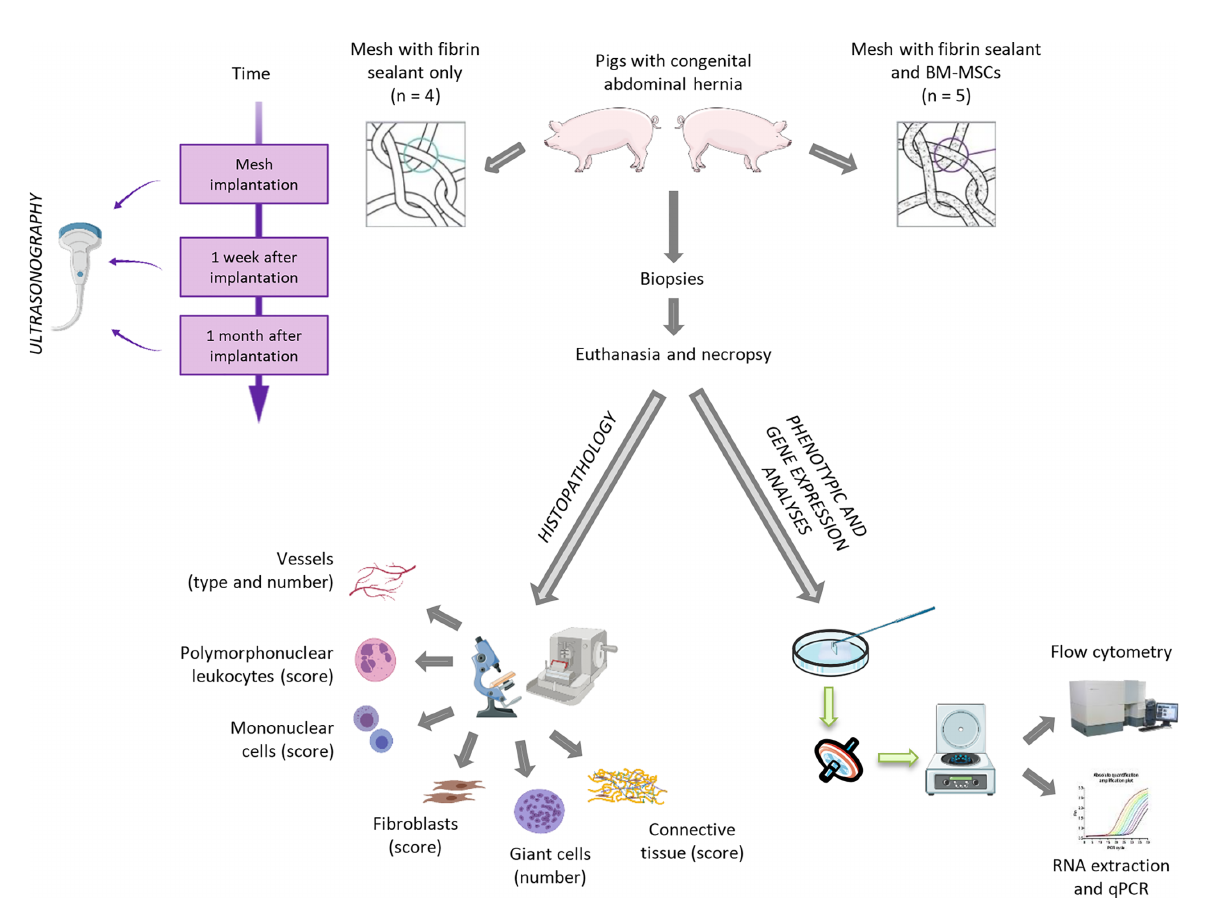
FIGURE 1 | Overview of the experimental approach. Large White pigs with a congenital abdominal non-incarcerated hernia were randomly divided into “ control ” and “ cell ” groups. Polypropylene surgical meshes were covered with a fi brin sealant solution (control group) or with porcine bone marrow-derived mesenchymal stem cells (BM-MSCs) (cell group) and were implanted into the animals by laparoscopy. All animals were then biopsied (1 week after implantation) and euthanized prior to the excision of the surgical mesh (1 month after implantation). Prior to all surgeries, an ultrasonographic examination of the hernia was carried out to record the maximal diameter of the hernia ori fi ce. Flow cytometry and histological and gene expression analyses of the biopsy and necropsy samples were performed. qPCR, quantitative real-time polymerase chain reaction. Mesh images are taken from Marinaro et al., 2019. The entire fi gure has been created with BioRender (https://app. biorender.com/) and Smart Servier Medical Art